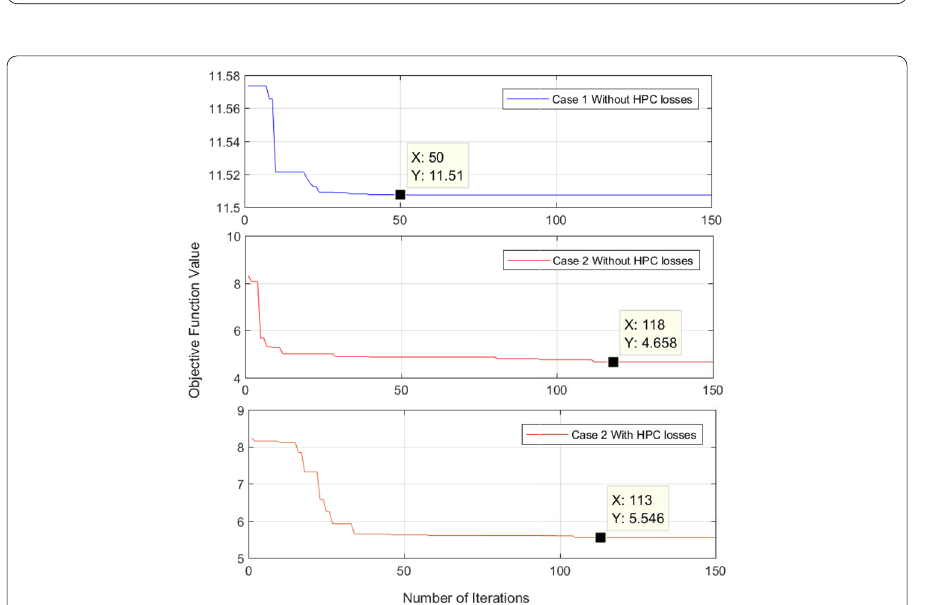
Fig. 9 Case-wise convergence characteristics obtained by BO algorithm for 69-bus hybrid AC/DC distribution